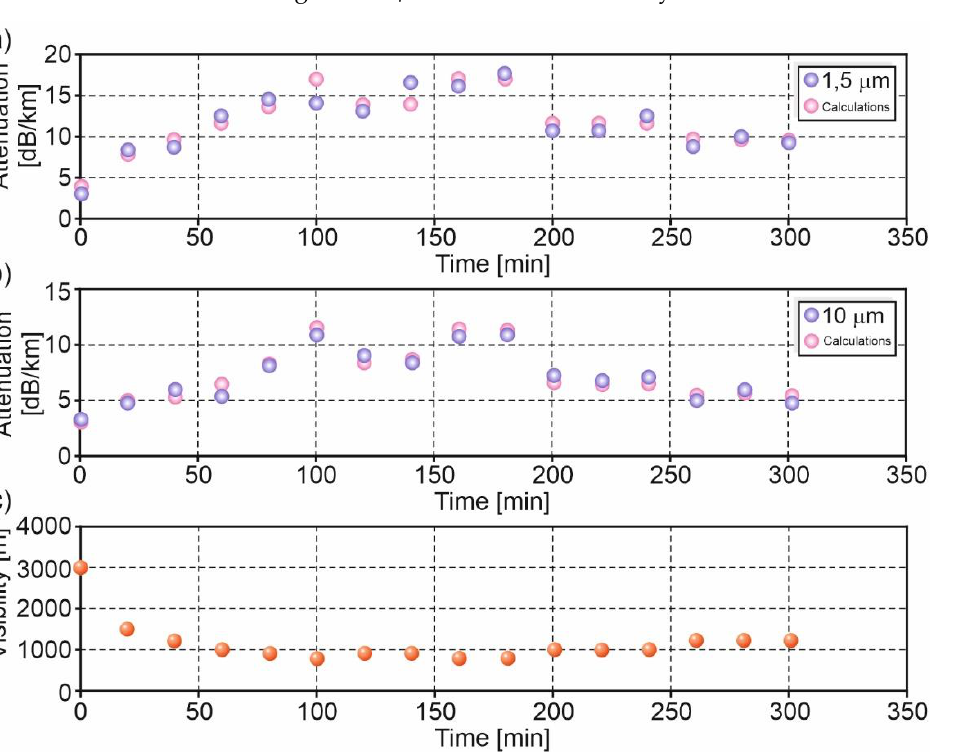
Figure 12. Experimental results in the real conditions for a light haze (violet) with marked theoretical calculations (pink) in the case of ( a ) attenuation of the wavelength 1.5 µm, ( b ) attenuation of the wavelength 10 µm ( c ) visibility.